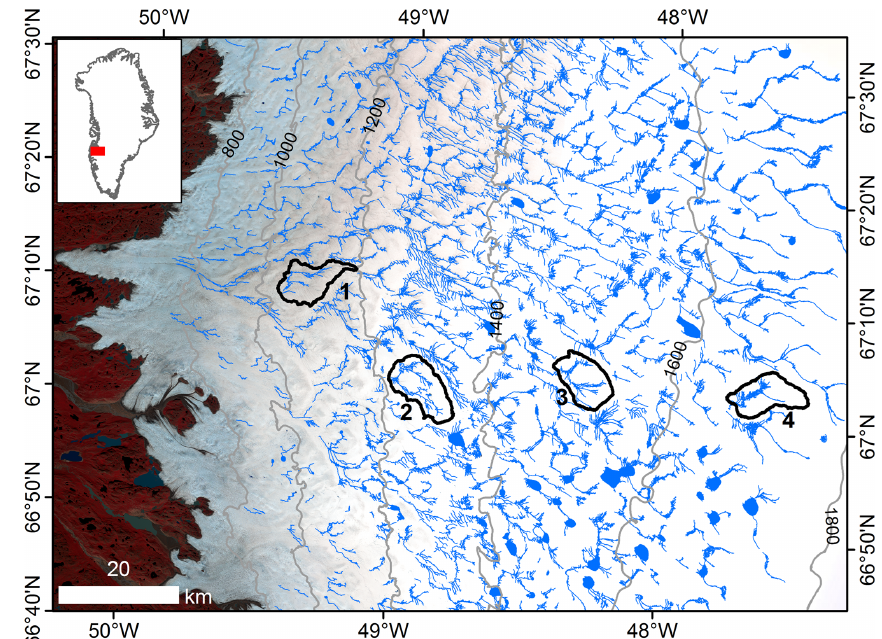
Figure 1. Four supraglacial internally drained catchments (IDCs) on the southwestern Greenland ice sheet were selected for intercompari- son of surface meltwater routing models. IDC topographic boundaries (black lines) are extracted from high-resolution (2m) ArcticDEMs. Supraglacial river networks and lakes (blue lines) are mapped from a Landsat-8 panchromatic image (Yang and Smith, 2016). The base map is 10m Sentinel-2 image acquired on 30 July